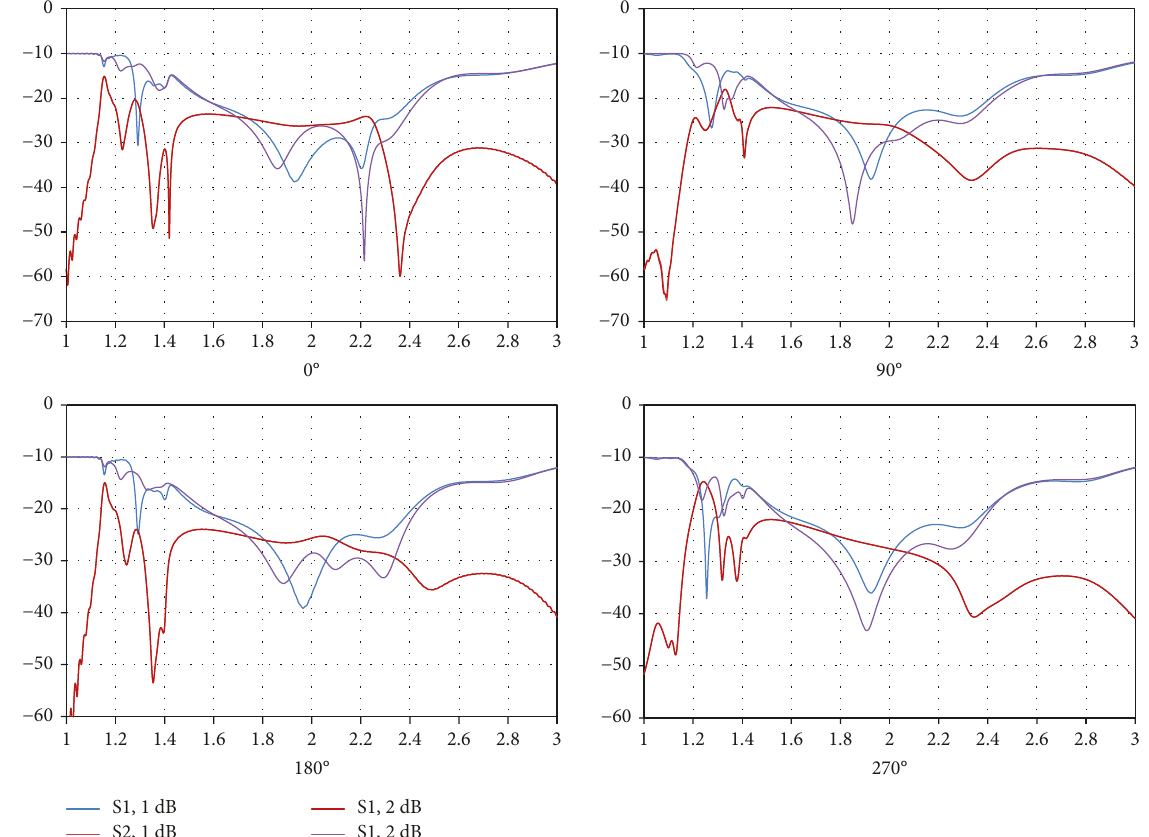
Figure 4: Simulation of S -parameters of dual-element antenna array